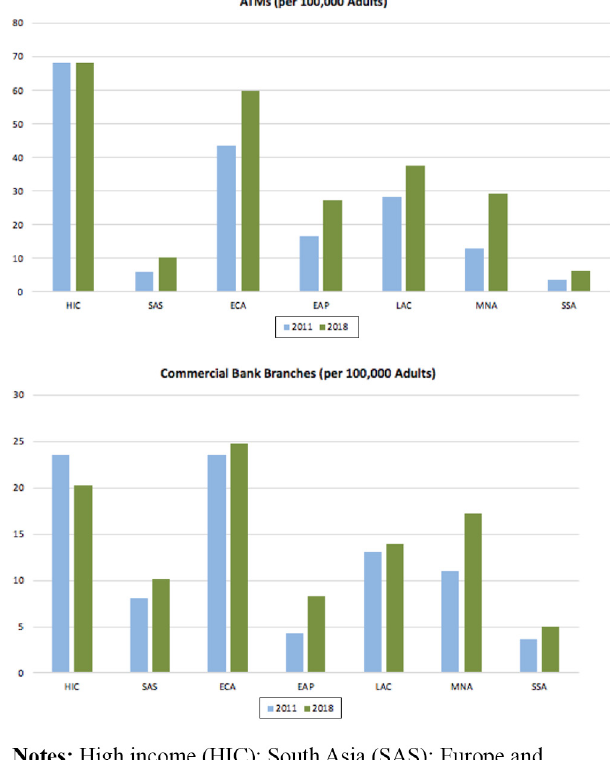
Figure 3. ATMs and commercial bank